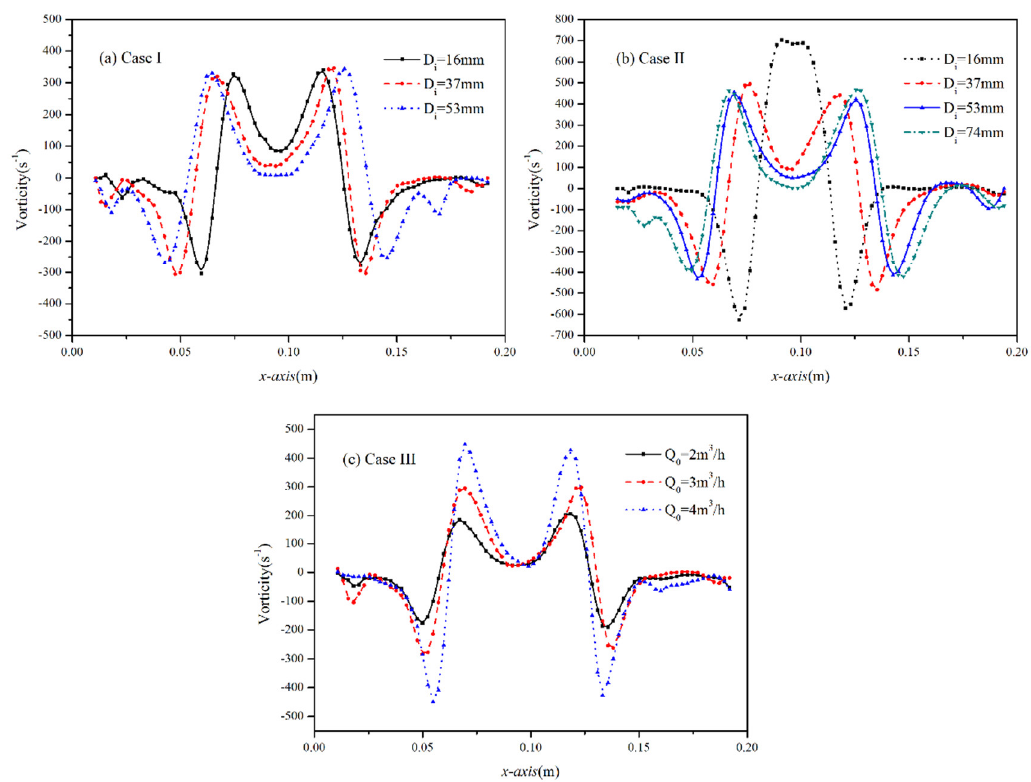
Figure 7. The gas vorticity distribution ( ω z ) along the centerline under three cases.